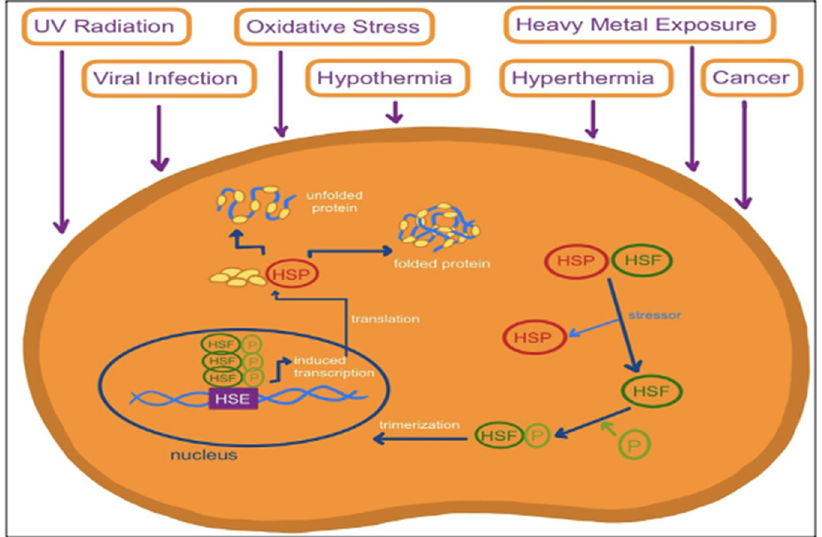
Figure 2. The molecular mechanism for the synthesis of heat shock proteins (HSPs). Under physiological conditions, an HSP and a heat shock factor (HSF) are a complex found in the cytosol in an inactive state. However, stressors such as UV radiation, viral infection, heavy metal exposure, oxidative stress, hypothermia, hyperthermia, and cancer cause HSFs to become detached from HSPs. HSFs undergo phosphorylation and trimerization. Once inside the nucleus, they bind to heat shock elements (HSEs), initiating transcription. The HSP mRNAs then leave the nucleus and are translated, synthesizing new HSPs. These HSPs then act as molecular chaperones and bind to polypeptide chains to prevent misfolding of proteins. To protect cells, HSPs also repair and refold damaged proteins under stressful